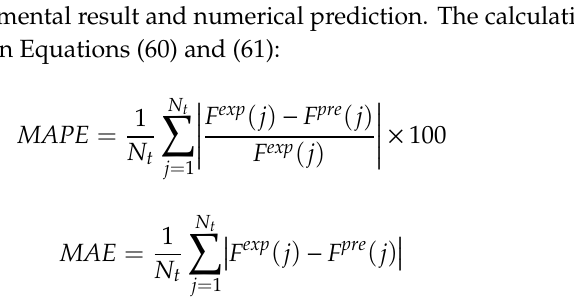
The relative deviations between the improved LuGre friction model and the Kelvin–Voigt model, four-parameter viscoelastic model, rheological model, BW model, improved BW model, Dahl model, improved LuGre friction model, strain sti ff ening model, and hyperbolic hysteresis model are 361.27%, 346.04%, 340.10%, 130.89%, 31.29%, 44.05%, 198.69%, and 119.80% for RMSE index, 253.83%, 228.04%, 215.16%, 57.07%, 6.78%, 32.65%, 57.94%, and 35.66% for MAPE index, and 374.46%, 348.90%, 343.92%, 133.60%, 13.49%, 47.92%, 165.13%, and 103.66% for MAE index, respectively. As a consequence, it